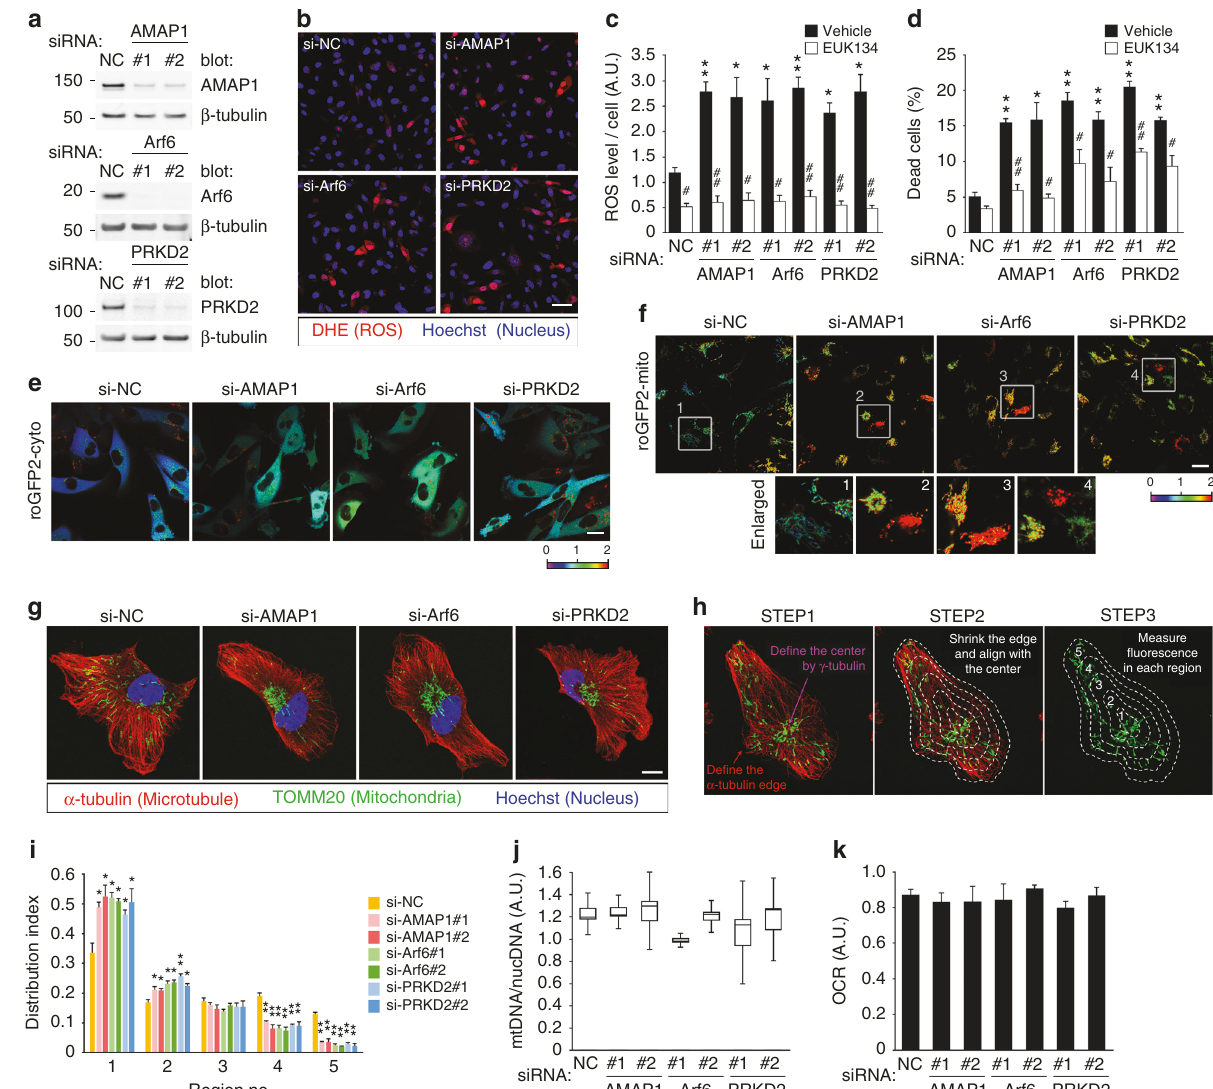
Fig. 1 The Invasive machinery based on the Arf6 – AMAP1 pathway regulates mitochondrial distribution and ROS levels. MDA-MB-231 cells were transfected with siRNAs (si-) targeting AMAP1, Arf6, or PRKD2, or the non-silencing control (NC) RNA duplex, as indicated. a Western blot of AMAP1, Arf6, or PRKD2. β -tubulin was used as a loading control (also for experiments hereafter). b ROS production was visualized by DHE (red). Nucleus staining with Hoechst 33342 (blue) is also shown. Bar, 50 μ m. c , d Quanti fi cation of DHE fl uorescence ( c ) and cumulative cell death ( d ) after siRNA transfection, in the presence or absence of 100 μ M EUK-134. e , f Subcellular redox state analyzed by roGFP2 localized to the cytoplasm (cyto, e ) or mitochondria (mito, f ). The numbered white squares in ( f ) indicate the enlarged areas shown beneath. The fl uorescence ratio of 405 – 488 nm excitation is shown by a heatmap. Bar, 20 μ m. g Immunostaining of TOMM20 (green) and α -tubulin (red) by speci fi c antibodies. The nucleus was stained with Hoechst 33342 (blue). Bar, 10 μ m. h Scheme of the quanti fi cation of mitochondrial distribution. i Mitochondrial distribution indices quanti fi ed as described in Methods. j Ratio of mitochondrial to nuclear DNA copy numbers, measured as a function of mitochondrial biosynthesis. The graph is a box-and-whisker plot showing the fi rst quartile, median, and third quartile, and the lower and upper error bars indicate the 1.5× interquartile range, respectively. k Relative oxygen consumption rate. All the graphs except for ( j ) indicate the mean ± standard error of the mean (SEM) for three independent experiments. * and # P < 0.05; ** and ## P < 0.005 (two-tailed t -test, adjusted by the Holm – Sidak method). * and **, comparison to si-NC samples; # and ## , comparison to the corresponding vehicle-treated